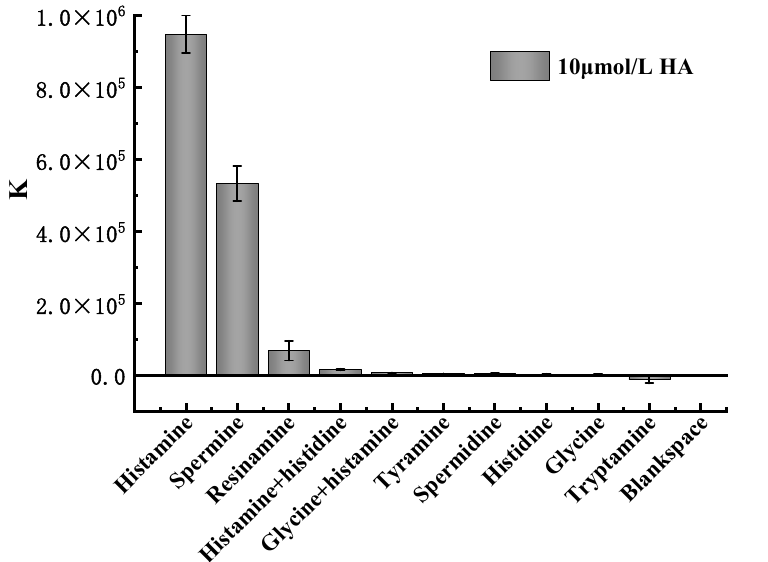
Figure 4. Specificity evaluation of the detection system based on the K signal value.